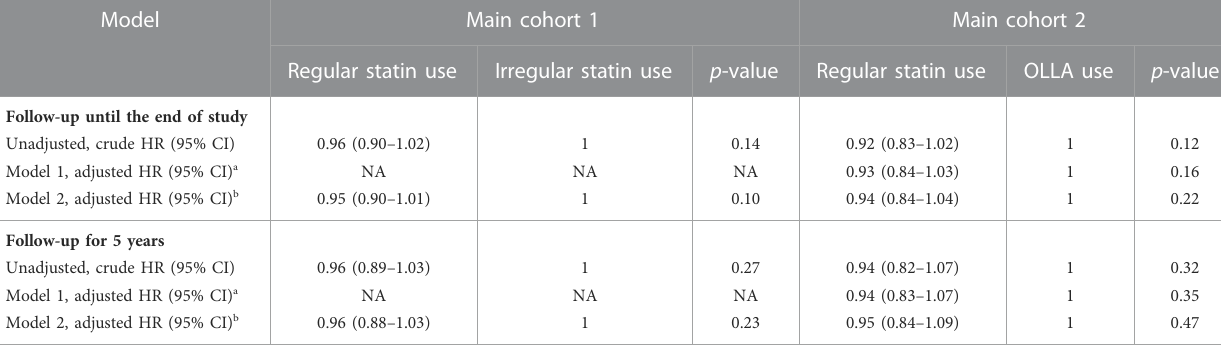
TABLE 2 Risk and sensitivity analyses for regular statin use and the gout risk in 2 main cohorts.